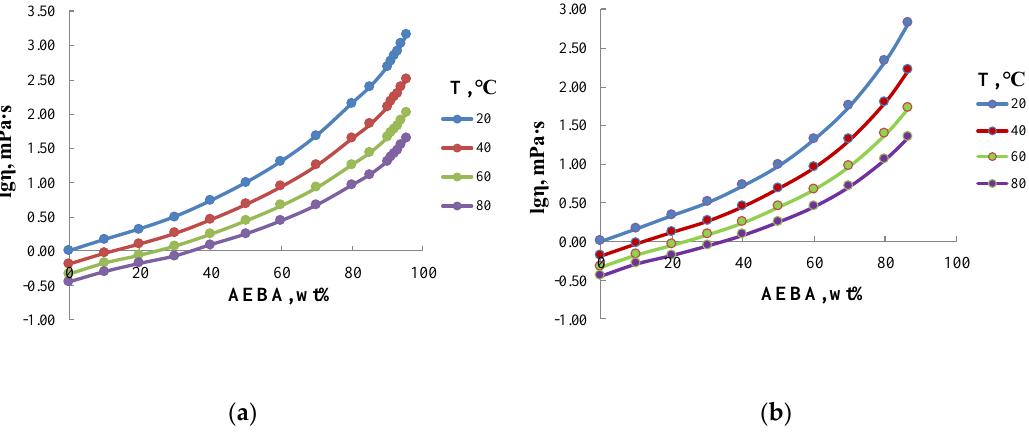
Figure 5. Dynamic viscosity of aqueous solutions of AEBA–TEG ( a ) and AEBA–DEG ( b ).